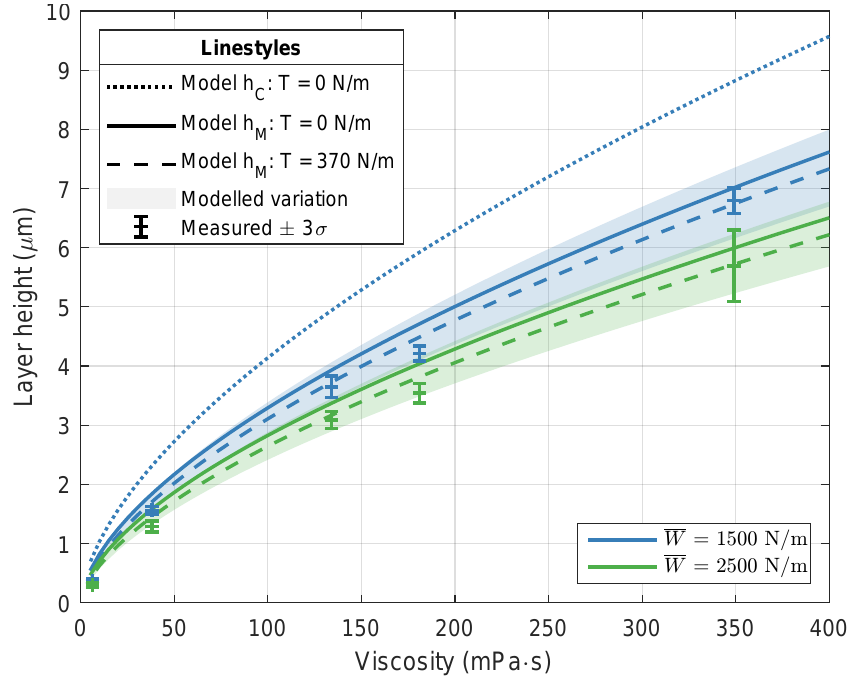
Figure 7. Numerical and experimental results for the layer height for varying imprint loads and resin viscosities. The modeled results include a ± 10% variation in both elastic modulus of the elastomeric layer and resin viscosity. The simulations and imprints are performed with a constant imprint velocity of 6.7mms − 1 . The imprints are performed with the resins as listed in Table